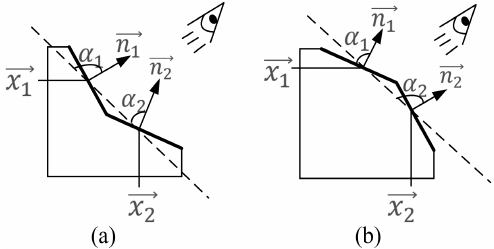
Figure 3. Basic principles of judging concavity and convexity adjacent patches for the locally convex connected patches (LCCP) method. ( a ) The relationship between the two patches is concave. ( b ) The relationship between the two patches is